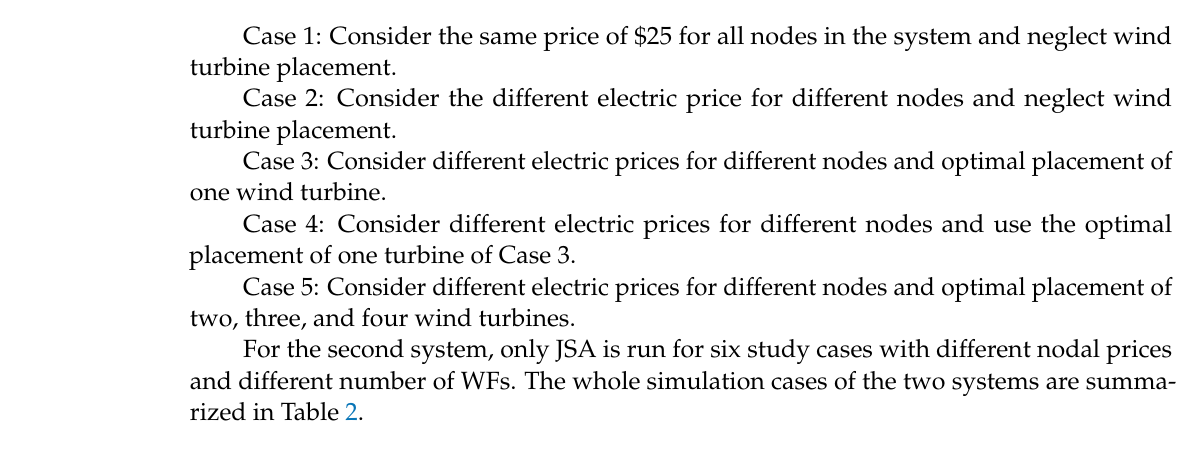
Table 2. Information of two employed systems and applied